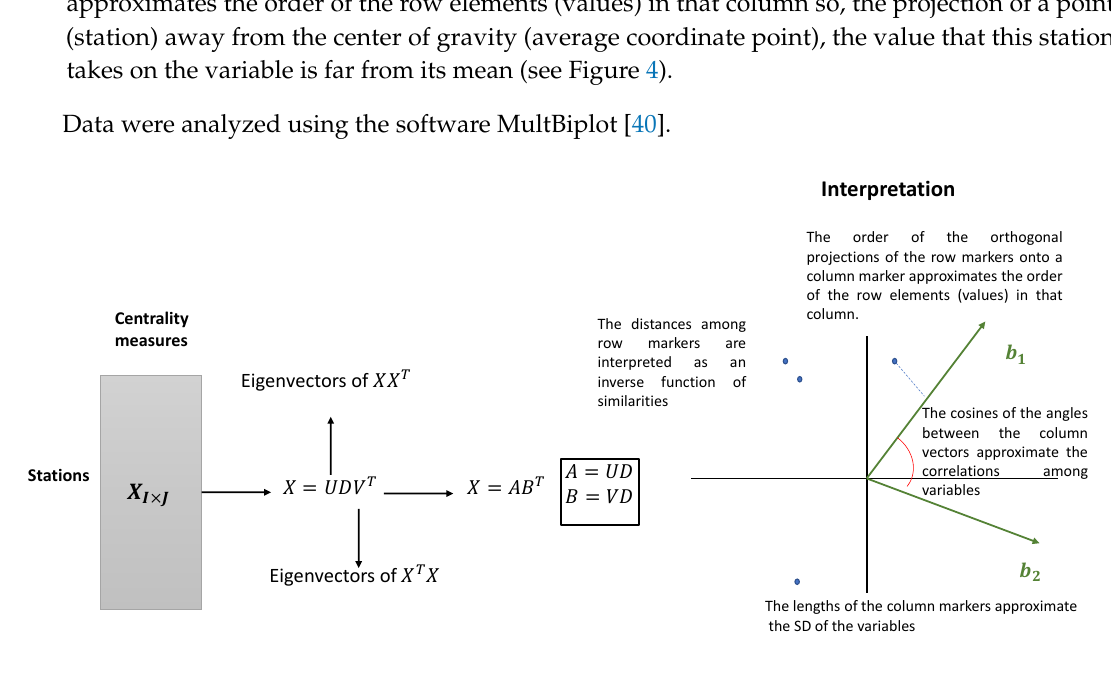
Figure 4. Phases of HJ-Biplot